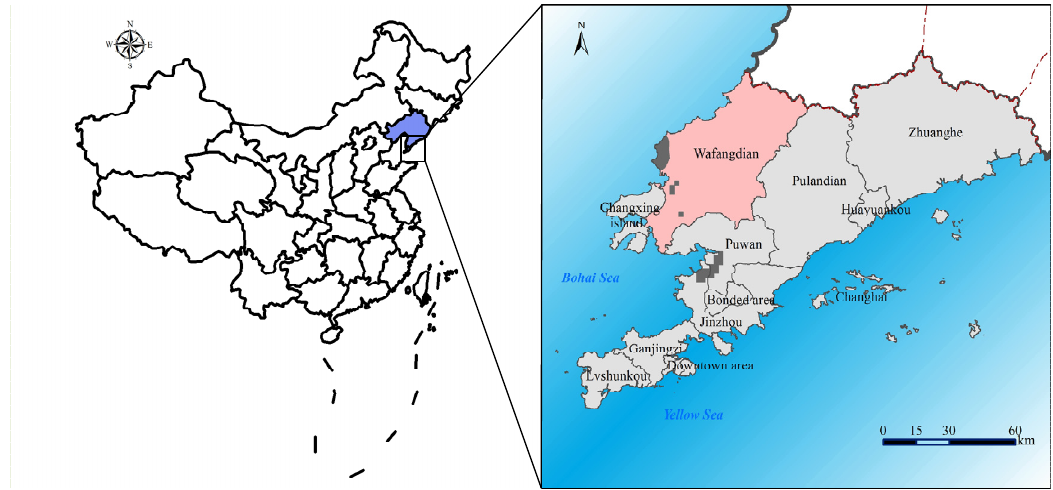
Figure 1. Study area.